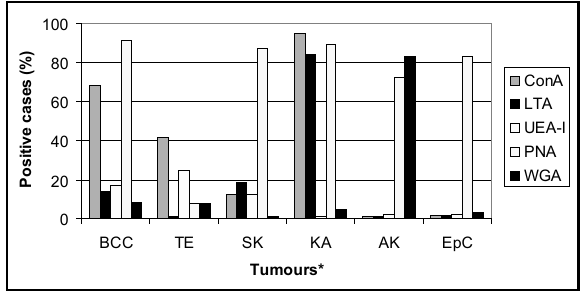
Figure 1 – Results of image analysis of stained cells area obtained to lectin histochemistry of skin’s neoplasms. * Basal cell carcinoma (BCC, n = 35), epidermoid carcinoma (EpC, n = 18), Figure 1. Results of image analysis of stained cells area obtained to lectin histo- trichoepithelioma (TE, n = 12), keratoacanthoma (KA, n=19), seborrheic keratosis (SK, n = 10) chemistry of skin's neoplasms. * Basal cell carcinoma (BCC, n=35), Epidermoid and actinic keratosis (AK, n = 18). Lectins: Con A (concanavalin A), WGA (wheat germ agglutinin), carcinoma (EpC, n=18), Tricoepithelioma (TE, n=12), Keratoacantoma (KA, n=19), Seborreic keratosis (SK, n=10) and Actinic keratosis (AK, n=18). Lectins: Con A (Concanavalin A), WGA (Wheat germagglutinin), PNA (Peanut agglu- tinin), UEA-I ( Ulex europaeus agglutinin) and LTA ( Tetragonolobus purpurea agglutinin). Totalarea analyzed per slice: 12,234 µ m 2